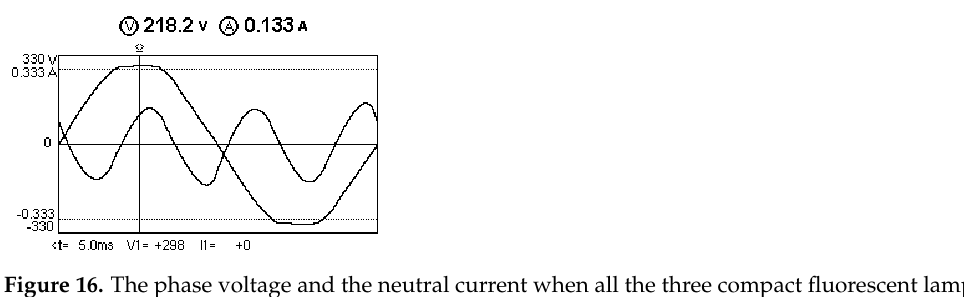
Figure 15. The phase voltage and the neutral current when two compact fluorescent lamps are supplied at different phase L 1 and L 2 (set 4).